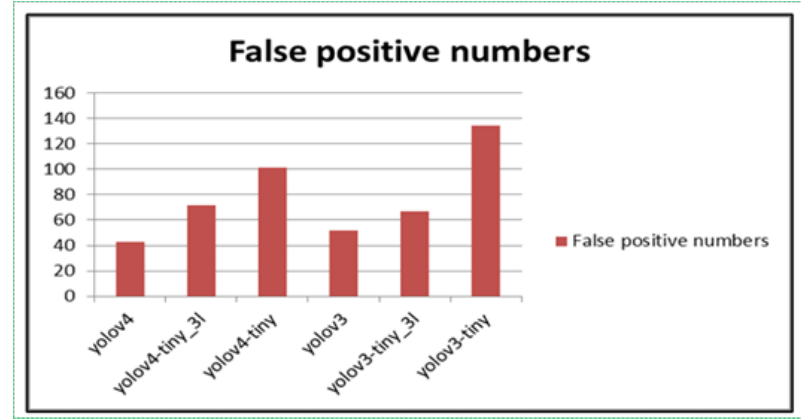
Figure 10. Second experiment’s weighted file results on false-positive tests.